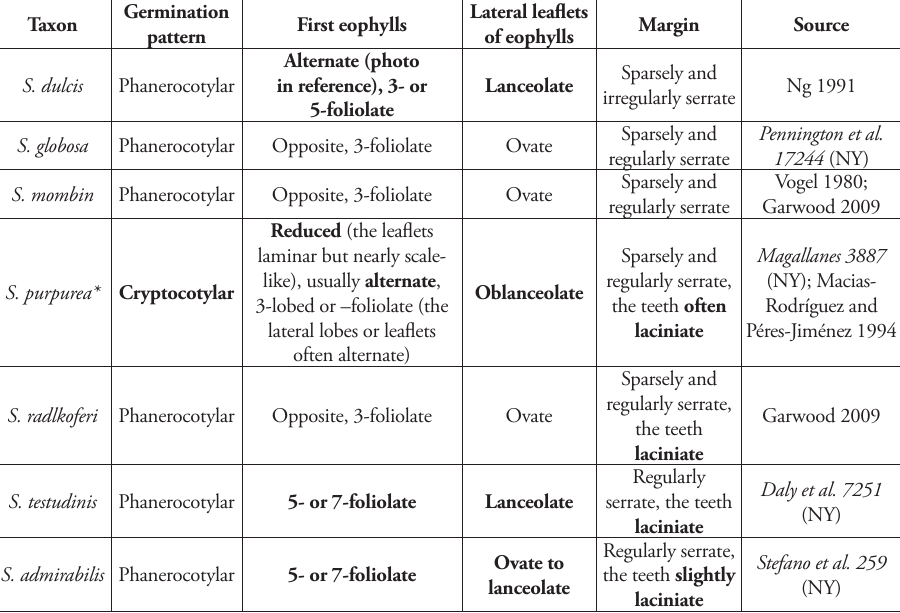
Table 3. Germination patterns and seedling morphology in Neotropical Spondias. [NOTE: table in- cludes only species for which observations/literature are available; unusual character states in bold]